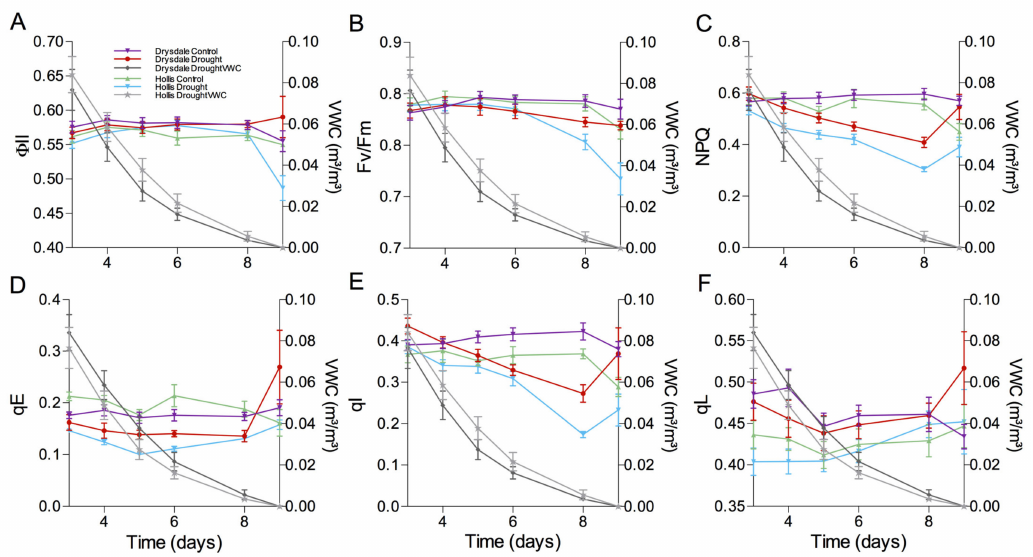
Figure 2. Impact of drought on the photosynthetic parameters. ( A ) Quantum yield of photosys- tem II photochemistry ( φ PSII ). The right Y-axis shows volumetric water content (VWC) at the corresponding time points. ( B ) The quantum efficiency of open photosystem II centers (F v /F m ). ( C ) Non-photochemical quenching (NPQ). ( D ) Energy-dependent quenching (qE). ( E ) Photoin- hibitory quenching (qI). ( F ) Open photosystem II centers (qL). The values represent the mean ± SD of 5 biological replicates for both control and drought